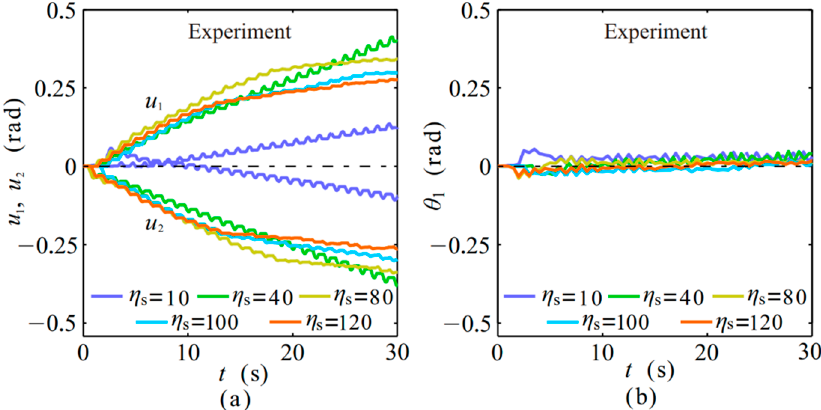
Figure 14. Serial-stiffness-switch system simulation results for harmonic disturbances under different dimensionless sampling frequencies η s , here η s = 100 and η d = 3. ( a ) Deformations of the two springs, u 1 and u 2 ; ( b ) displacement of the primary plate, θ 1 .